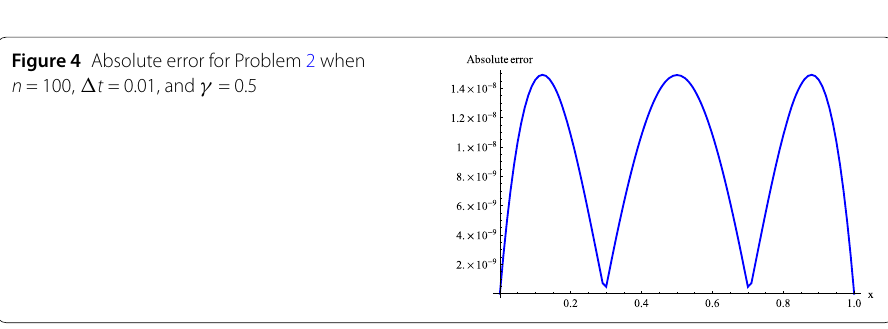
Table 5 Comparison of absolute errors for Problem 3 when n = 40 γ Method in [21] Proposed method (cid:12) t = 0.000001, t = 0.0001 (cid:12) t = 0.01, t = 1 L ∞ L 2 L ∞ L 2